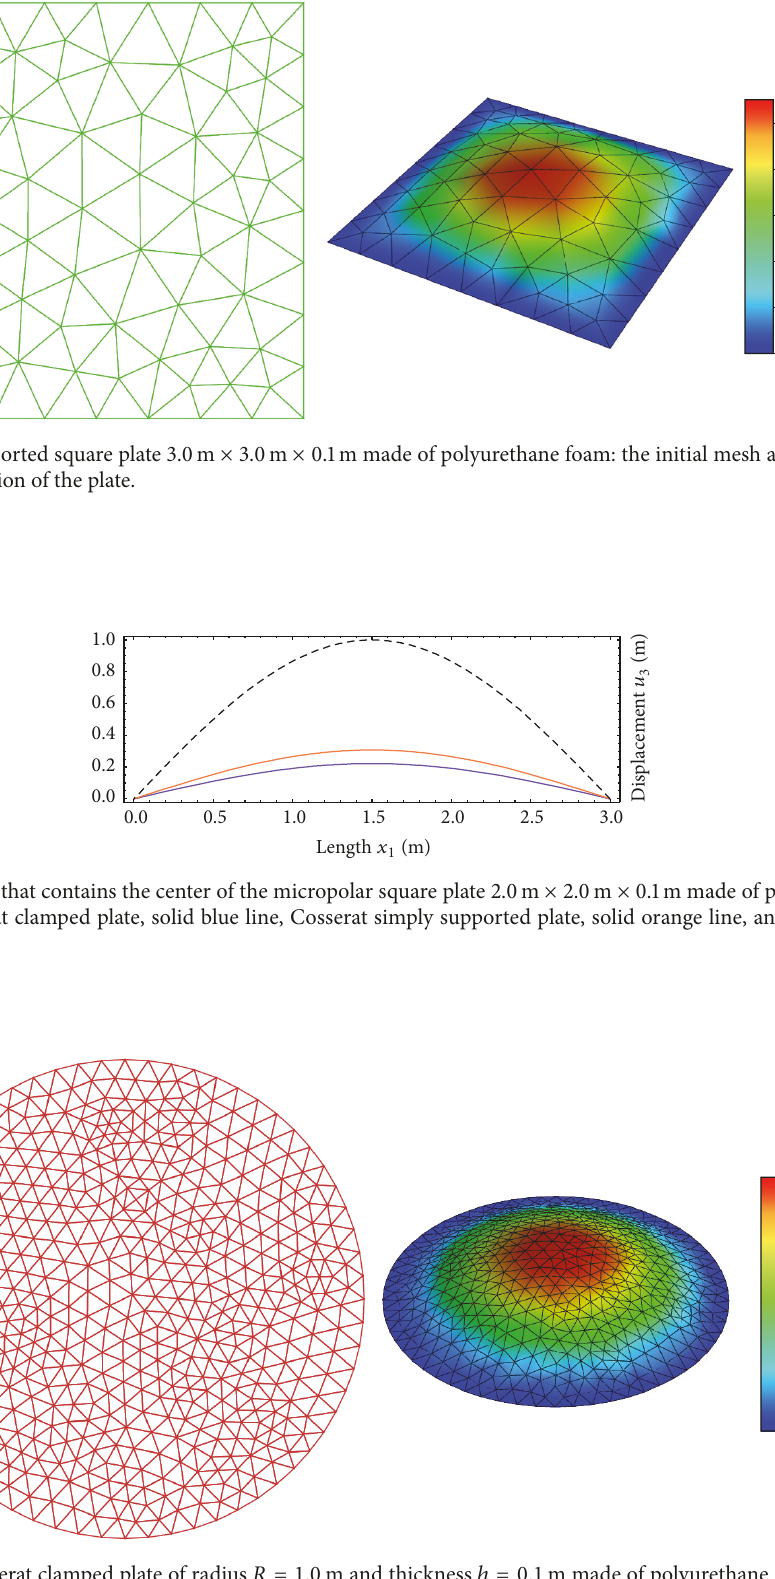
Figure 5: The circular Cosserat clamped plate of radius 𝑅 = 1.0 m and thickness ℎ = 0.1 m made of polyurethane foam under the uniform load: the initial mesh and the isometric view of the resulting vertical deflection of the